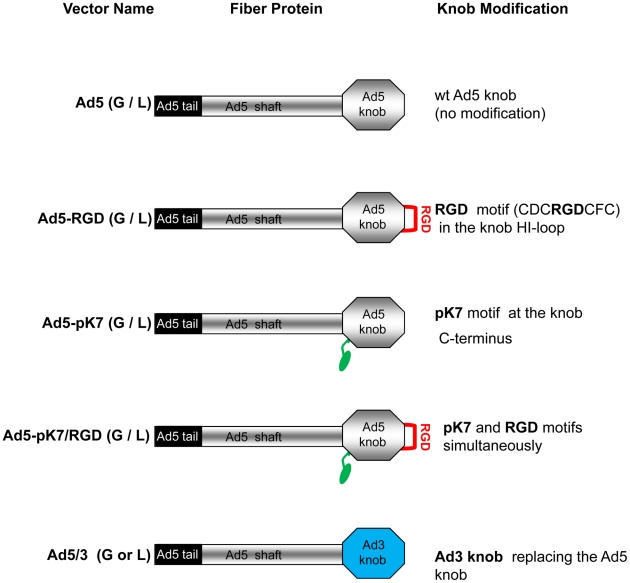
Schematic representation of the Ad5 fiber proteins carrying intact and modified C-terminal knob domains.Fiber modifications are indicated in the corresponding vector names: Ad5 (G/L) has unmodified fiber knob and possesses the native CAR tropism; Ad5-RGD contains a peptide ligand with an “RGD motif” in the HI loop (red loop) of the fiber knob; Ad5-pK7 contains a stretch of seven lysine residues (green oval) fused to the C-terminus of the Ad5 knob via a (GS)5 linker (green hook); Ad5-pK7/RGD incorporates both modifications in the corresponding locales of the same fiber molecule; Ad5/3 contains a chimera fiber with Ad5 fiber “knob” domain (gray) replaced with the Ad serotype 3 (Ad3) knob (blue), which retargets the vector to Ad3 receptor(s).